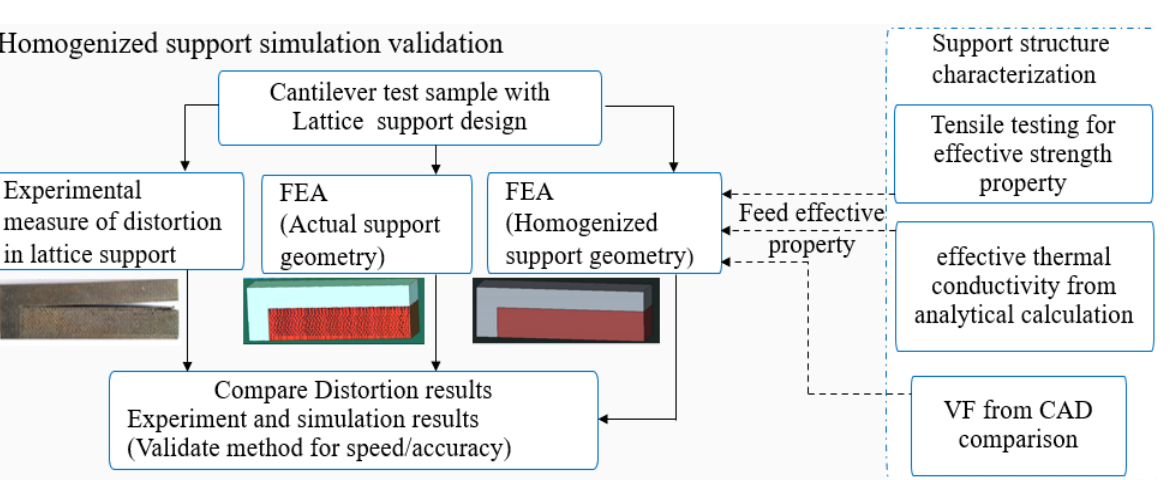
Figure 2. Flow chart for a homogenized support simulation approach.